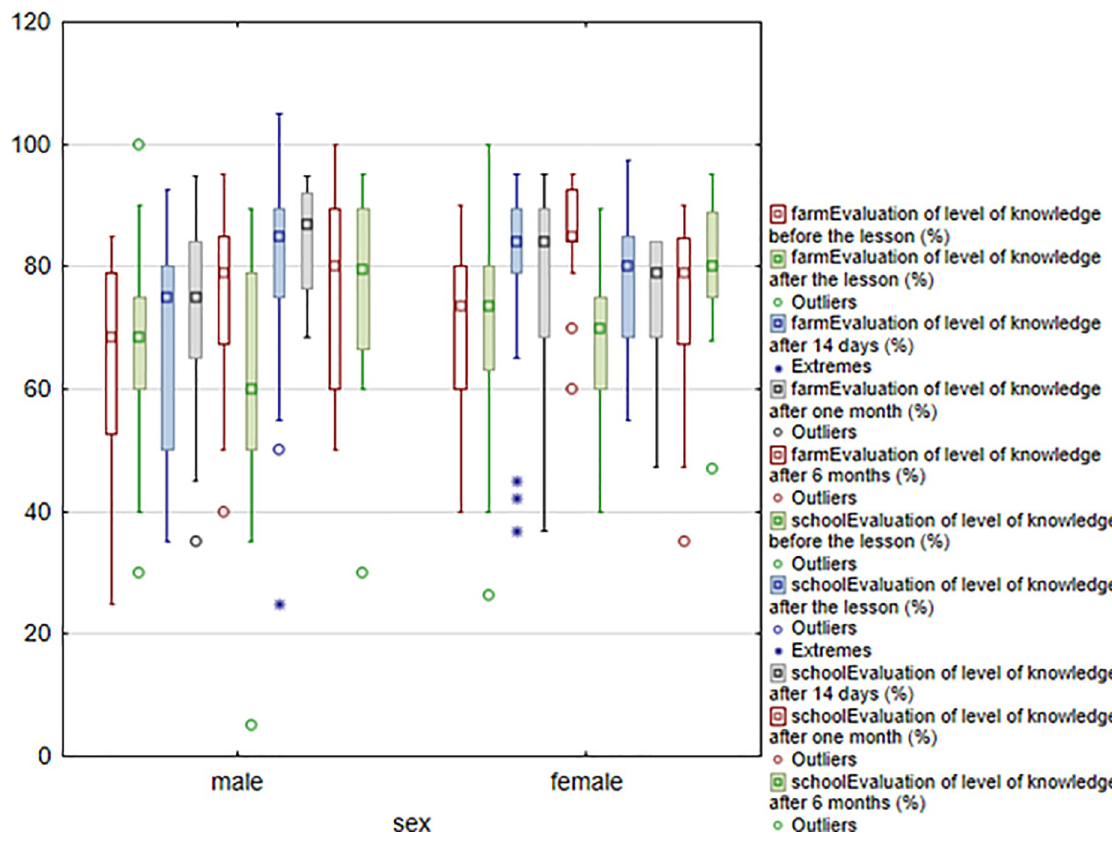
Fig 6. Boys’ and girls’ scores at the observed periods concerning place lesson